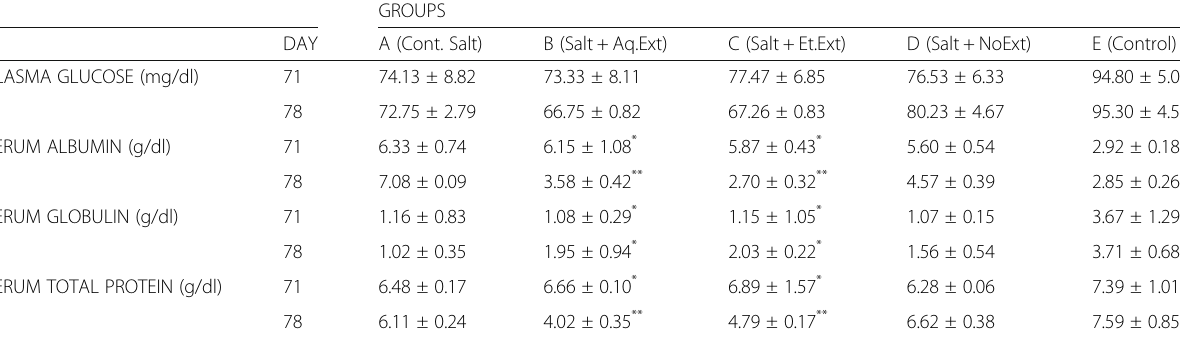
Table 2 Plasma Glucose (mg/dl) and serum Albumin, Globulin, Total Protein (g/dl) of salt-loaded rabbits; treated with aqueous (B) and ethanol (C) extracts of Acalypha wilkesiana leaves, continuous salt loading (A), salt loaded and non-treated (D), non-loaded and non-treated (E)